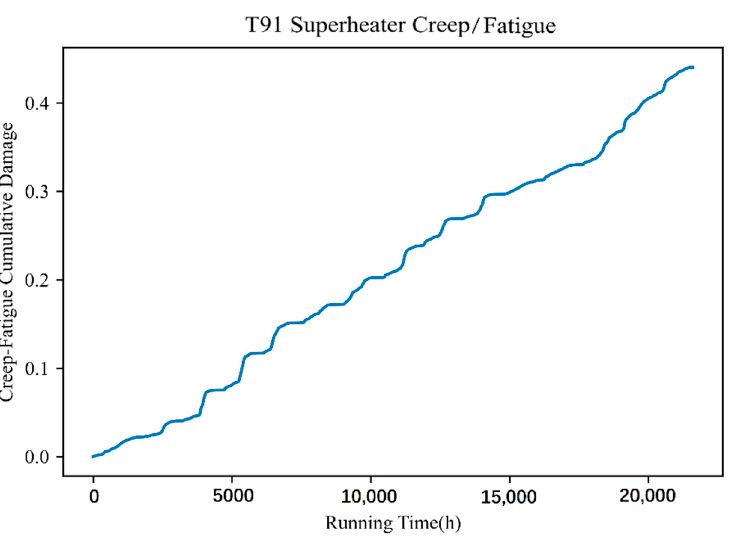
Figure 10. Relationship of creep–fatigue life and damage amount of final superheater T91 material.